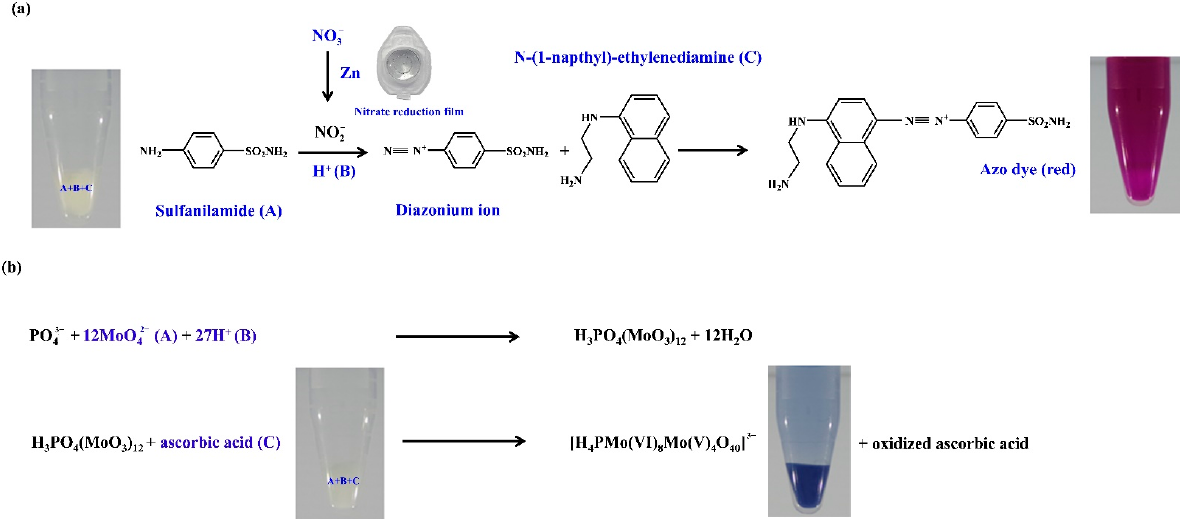
Scheme 1. The detection mechanism of ( a ) nitrate and nitrite, and ( b ) phosphate using hydrogel colorimetric test